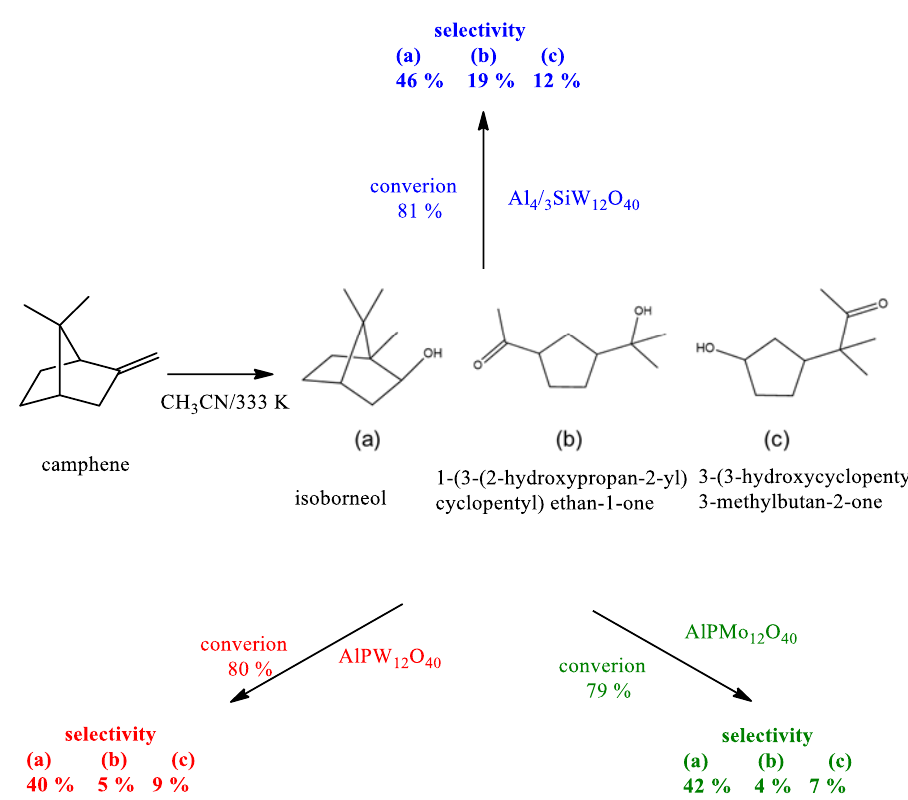
Scheme 9. Effect of Keggin anion on conversion and selectivity of Al 3+ heteropoly